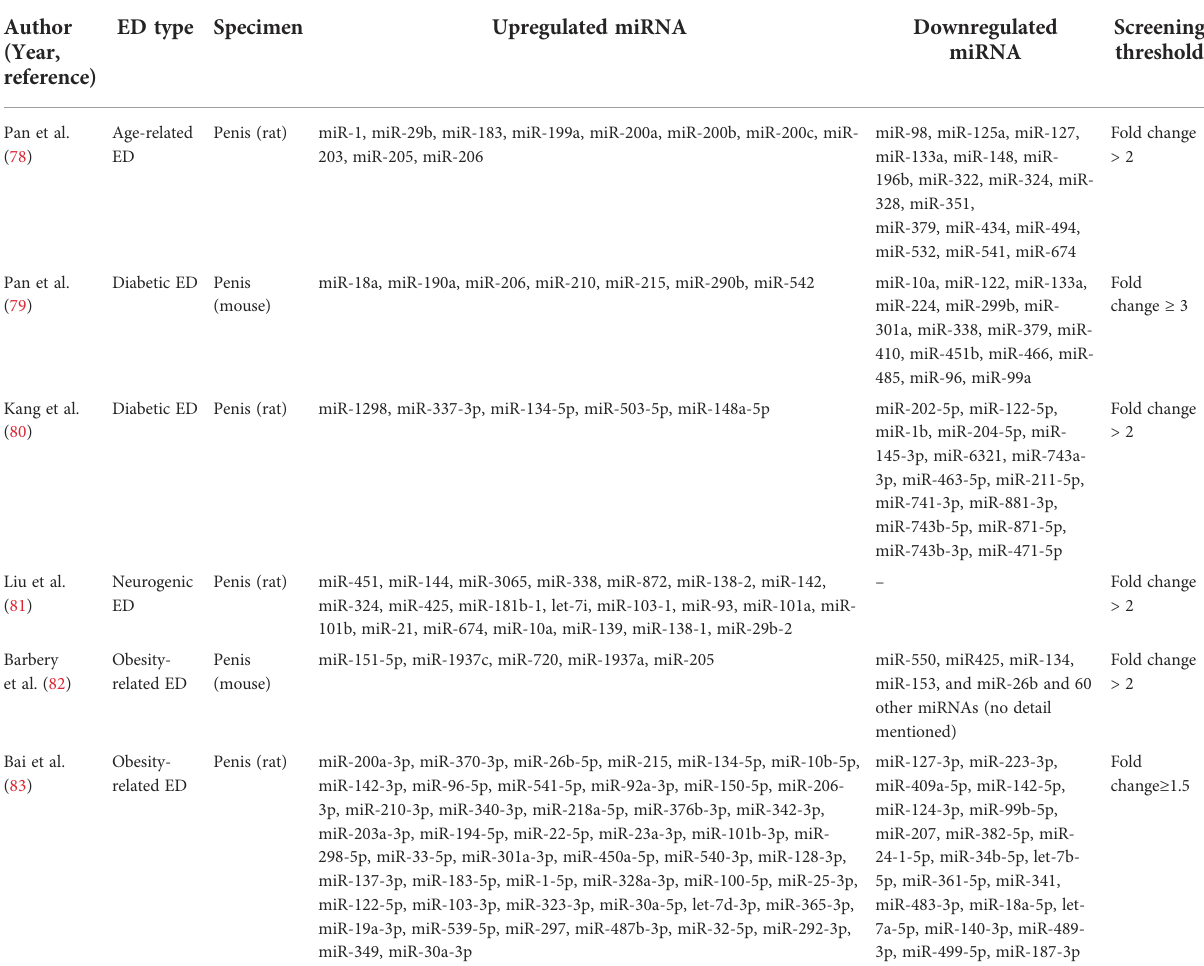
TABLE 1 miRNAs were screened by microarray analysis or